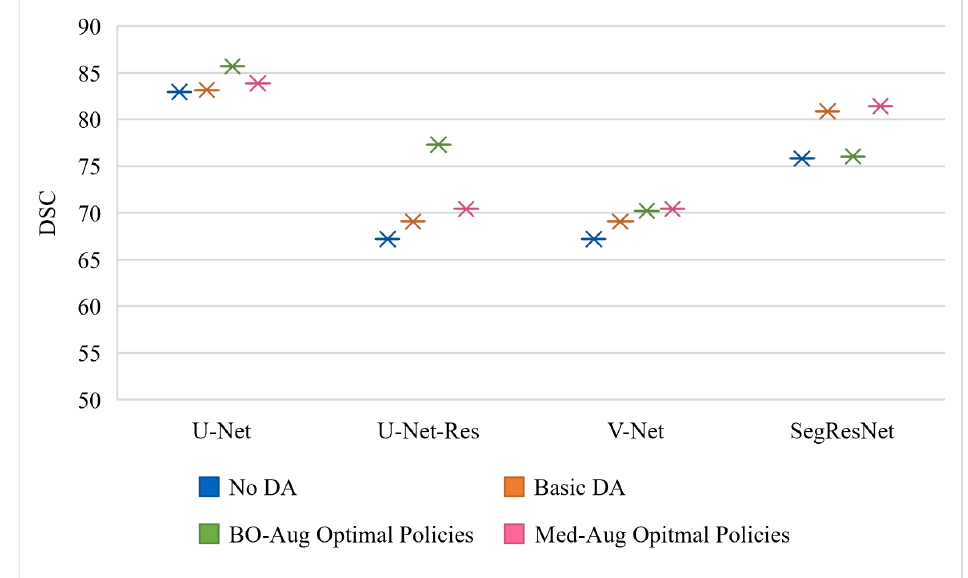
Figure 4. Visualization of the testing performance in DSC of four different neural networks using different DA policies on the training set for the Cardiac data experiments.